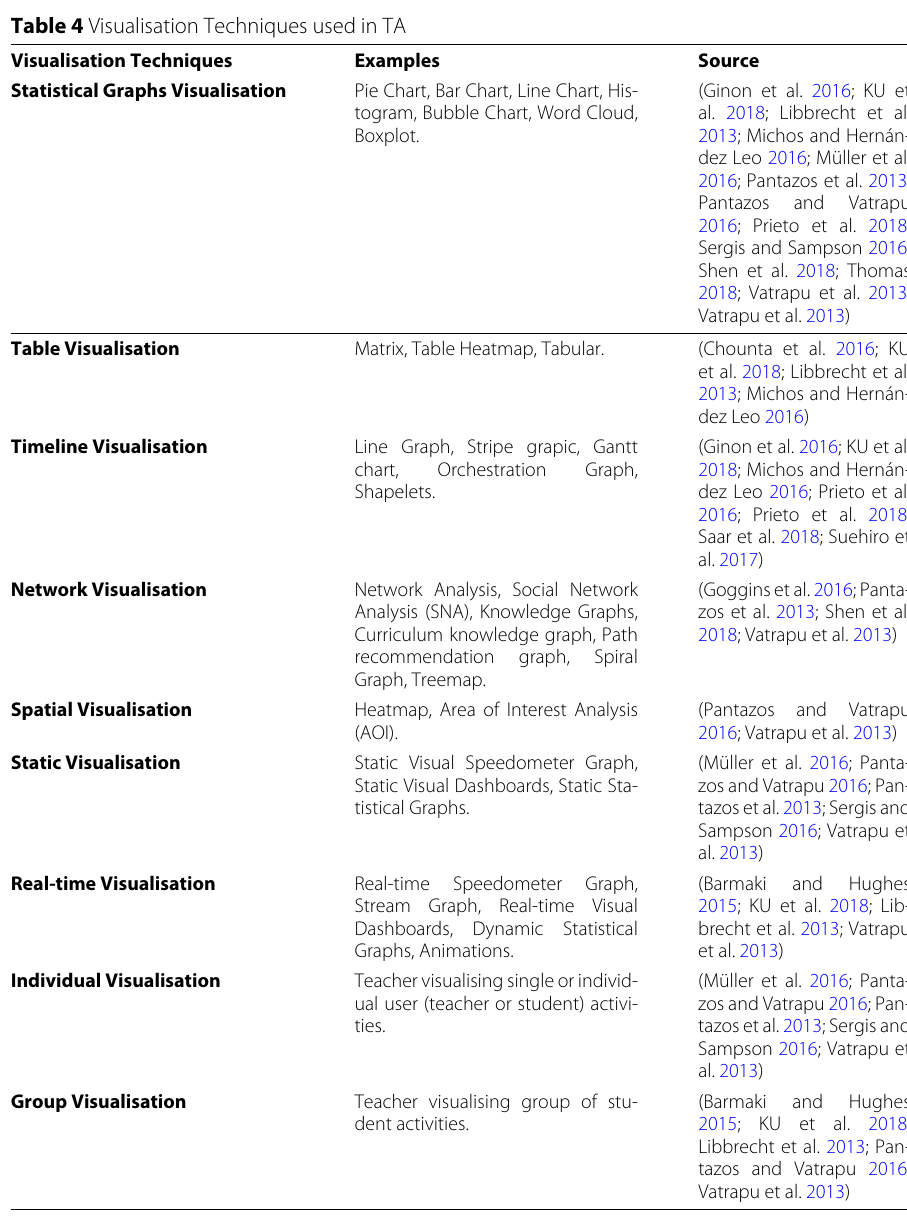
Table 4 Visualisation Techniques used in TA